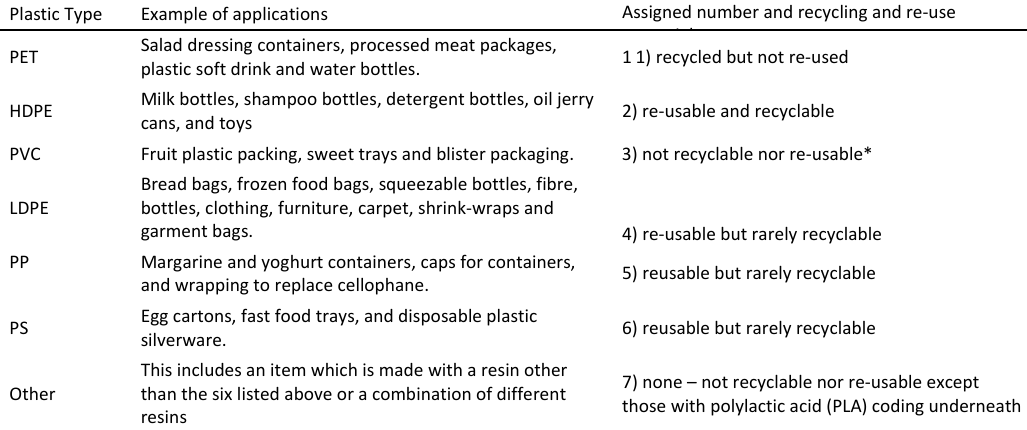
Table 1: Types of plastics and their recycling and re‐use potential (Seaman, 2012) Plastic